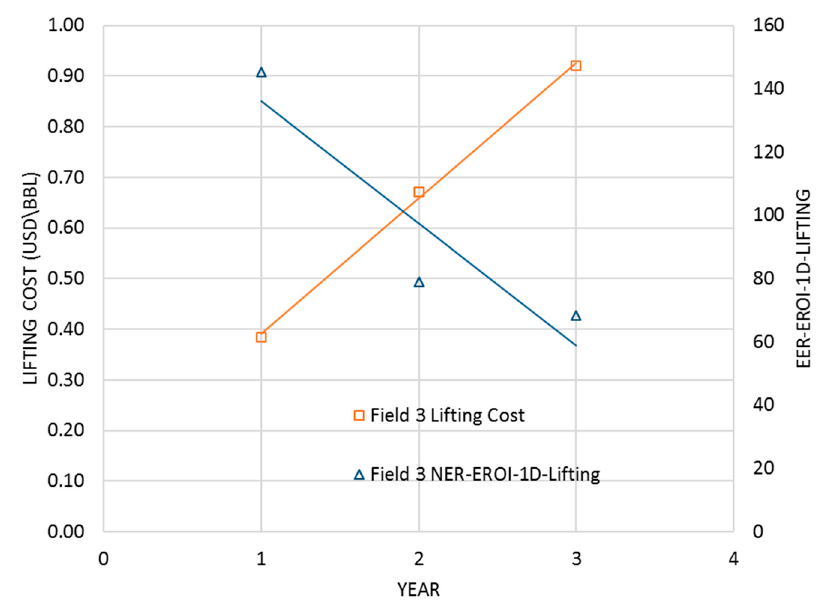
Figure 12. Lifting Costs and NER-EROI-1d Lifting vs. Time for Field 3.